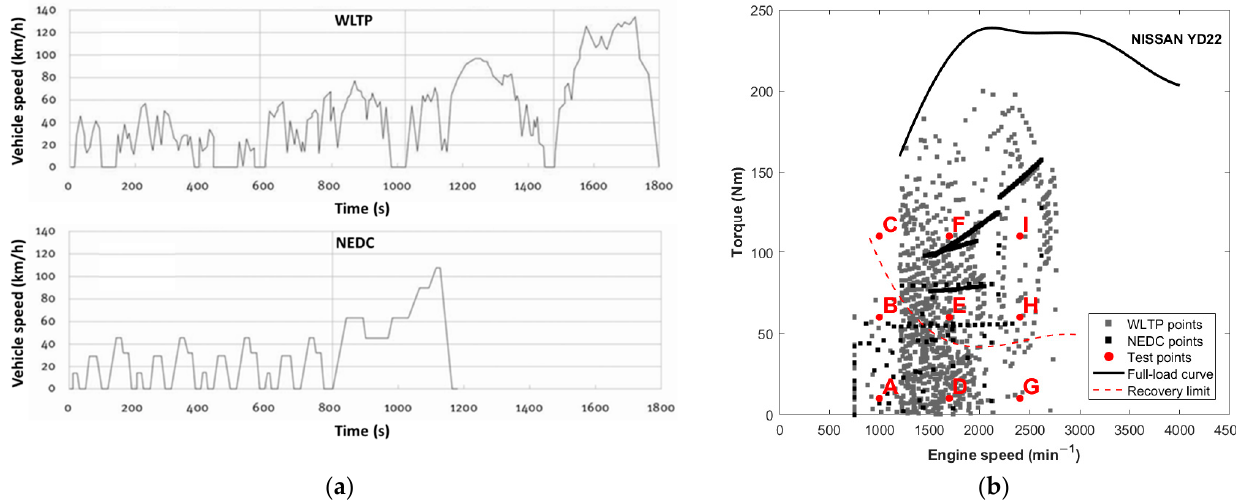
Figure 10. ( a ) Examples of the vehicle speed profiles under WLTP and NEDC certification cycles and ( b ) steady state operating modes translated by means of longitudinal dynamic equations for a vehicle.